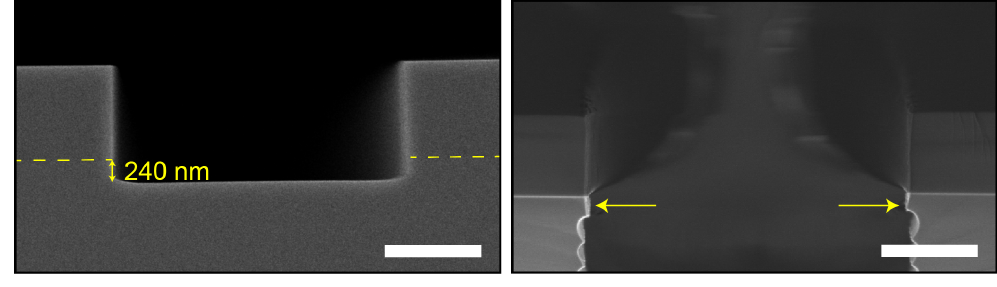
Figure 7. SEM images of the entrance effect. In ( a ) is the 240nm deep over-etch into the silicon substrate during the RIE step to pattern the t-SiO 2 hard mask layer. The dashed yellow line indicates the silicon–silicon-dioxide interface. In ( b ), the so-called “neck” is still visible after a Bosch-based DRIE and is indicated by yellow arrows. The scale bars in ( a , b ) are 1µm.